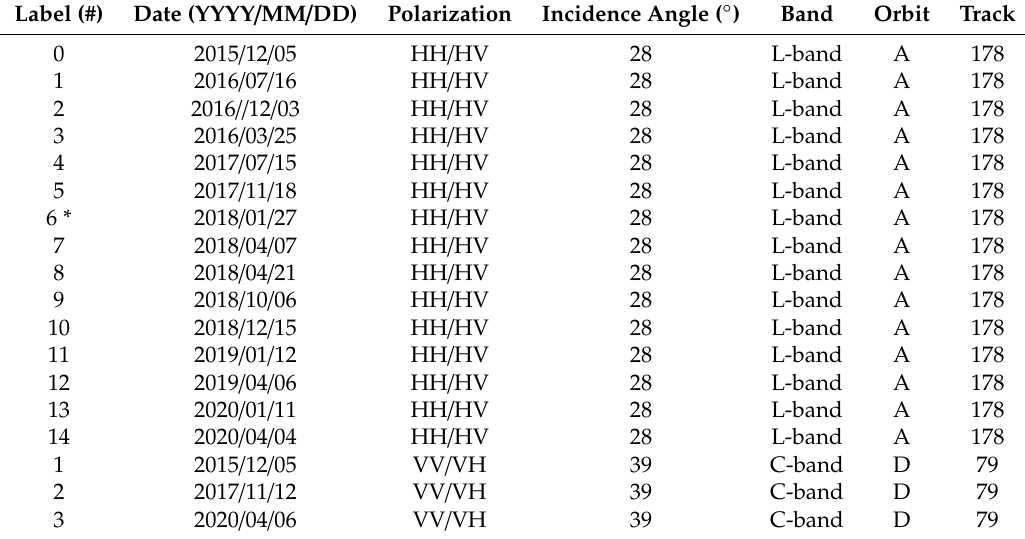
Table 1. Synthetic aperture radar (SAR) images and detailed characteristics of L-band PALSAR-2 and C-band Sentinel-1 datasets used in this study. * indicates super master image; D and A indicate descending and ascending orbits,